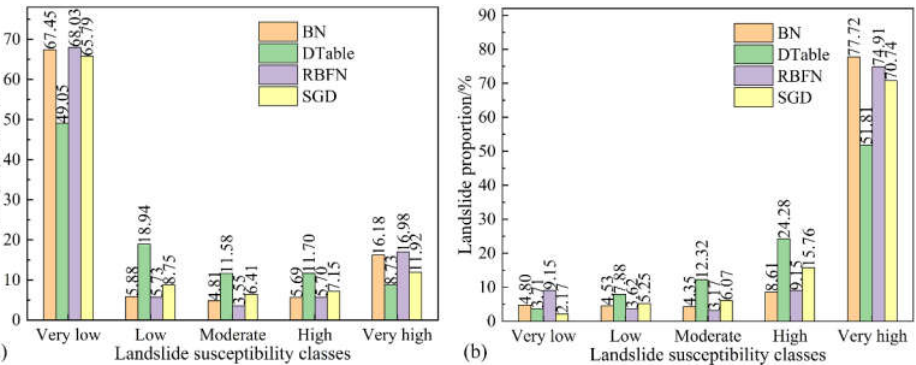
Figure 8. Quantitative analysis of the LSMs. ( a ) Area proportion of susceptibility classes. ( b ) Land- slide proportion in each susceptibility class.